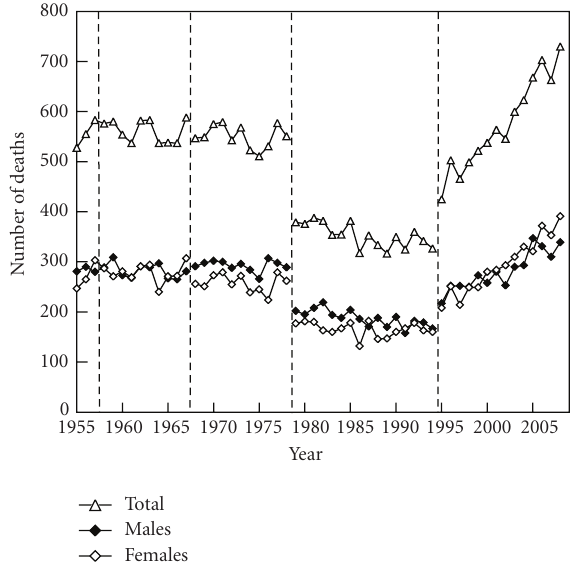
Figure 1: Annual trends in the number of deaths from non- melanoma skin cancer (NMSC) in Japan (1955 ∼ 2008), modified from Ohtsuka and Nagamatsu [7].